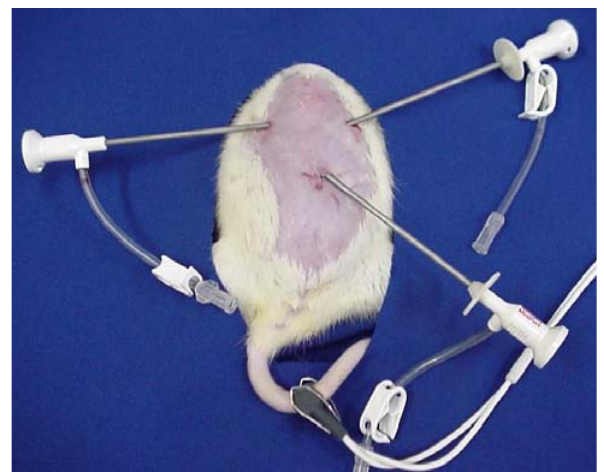
FIGURA 1 – Fotografia mostrando o posicionamento dos trocartes na parede abdominal do rato.